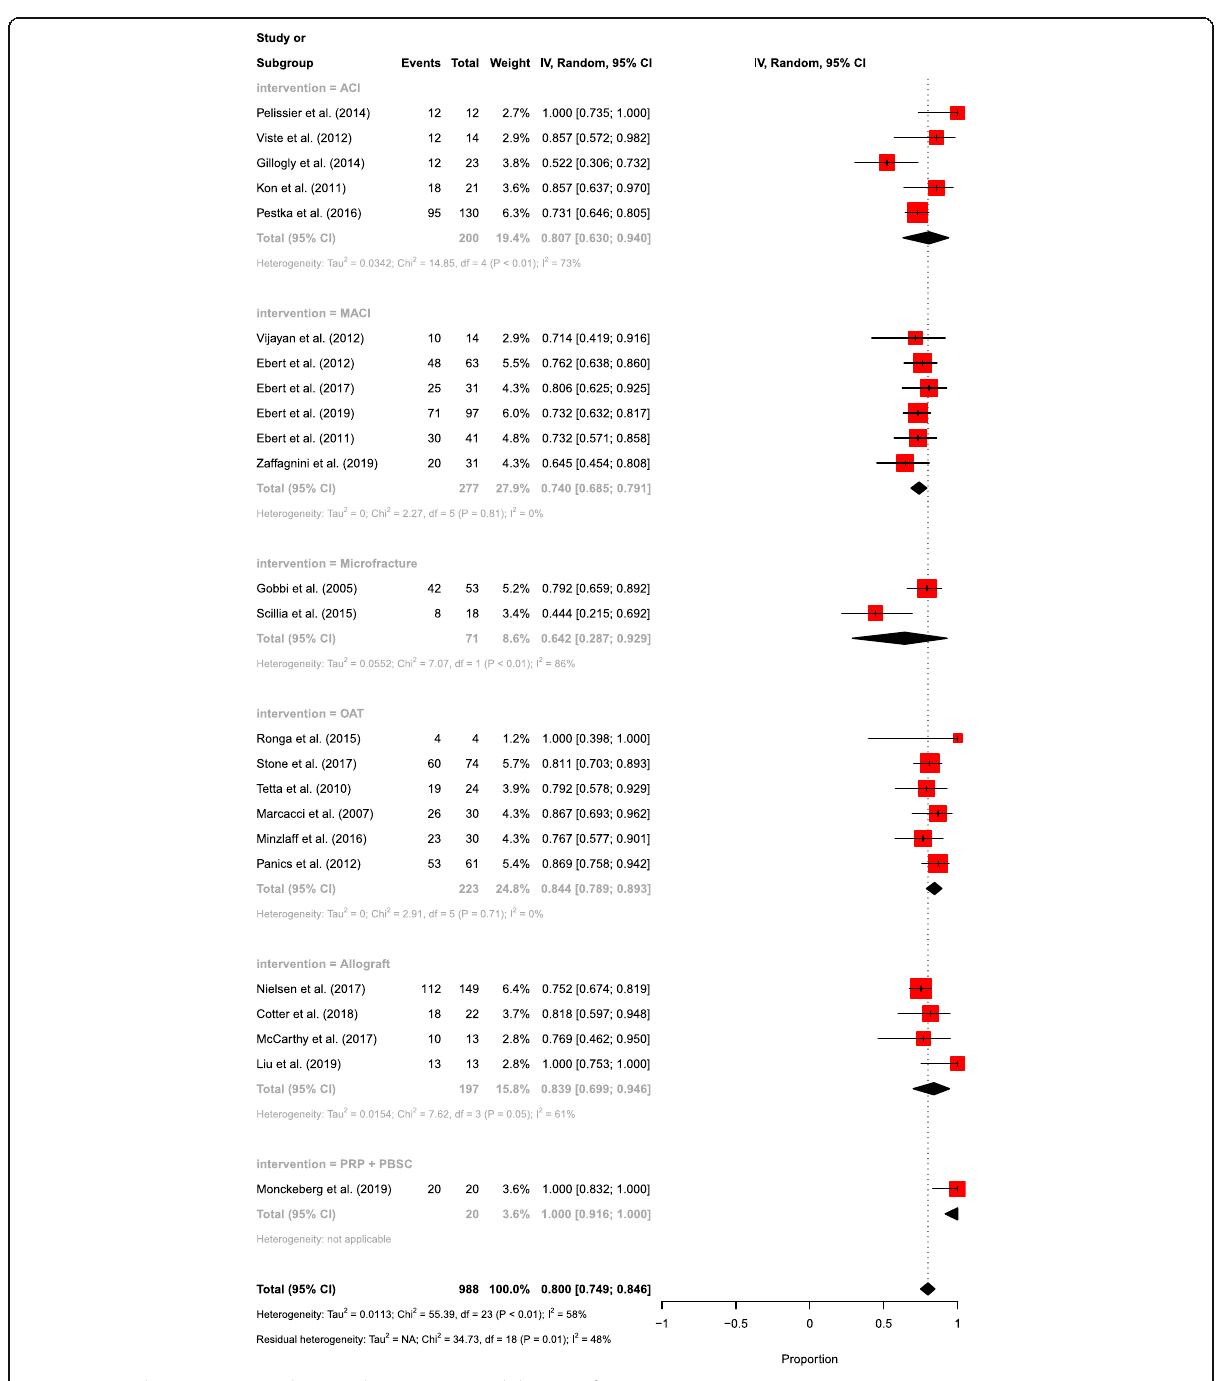
Fig. 2 Forest plot comparing each surgical intervention and the rate of returning to